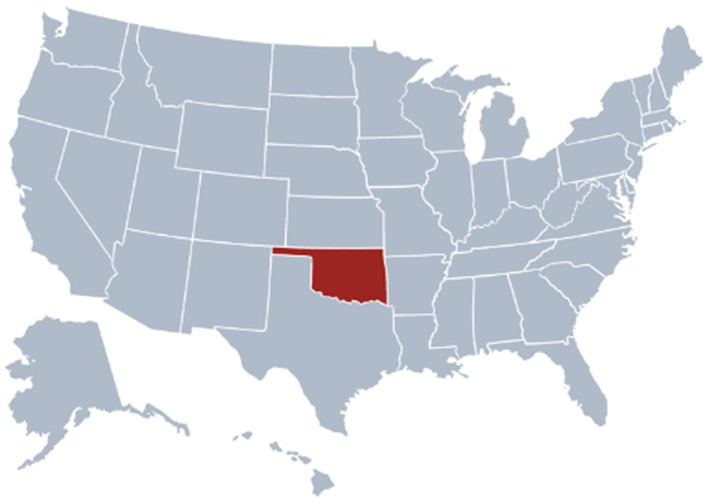
Map showing Oklahoma's geographical location in the USA.